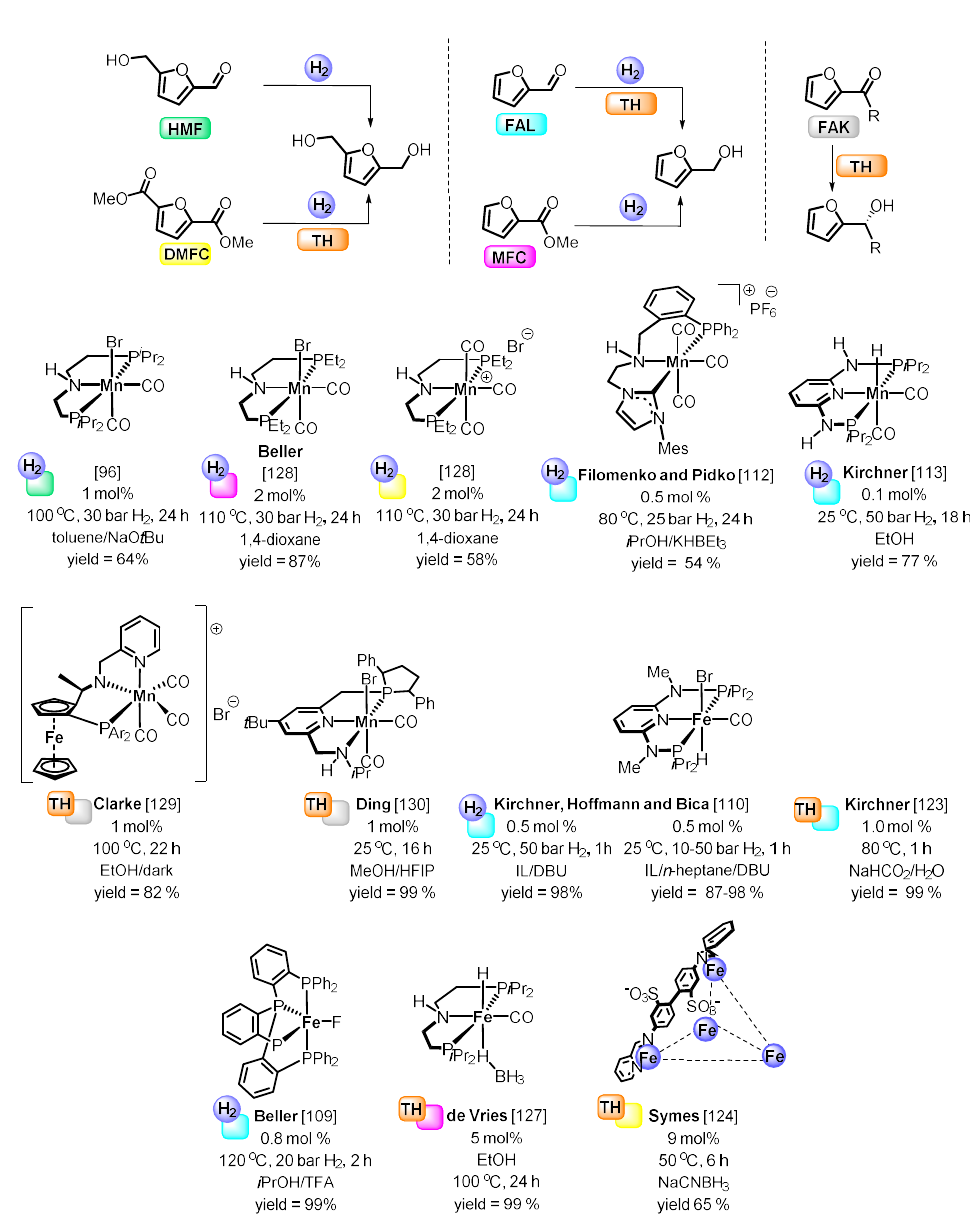
Figure 5. Base-metal complexes for the selective hydrogenation/transfer hydrogenation of furanic ketones as well as aldehydes and esters to alcohols.